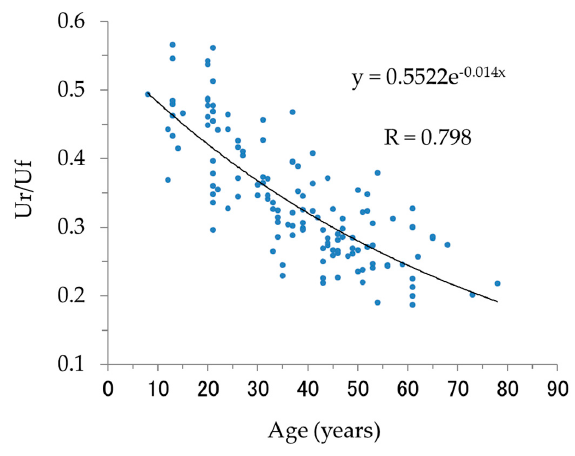
Figure 4. Biological elasticity (Ur/Uf) of Japanese female’s cheeks by age.